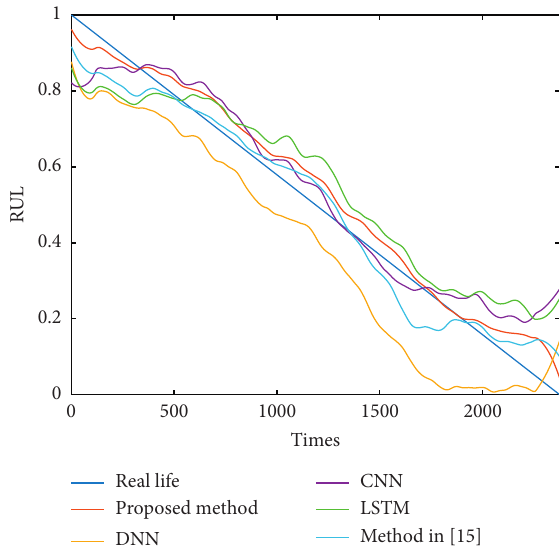
Figure 14: RUL estimation result of bearing 1_3 with different methods.